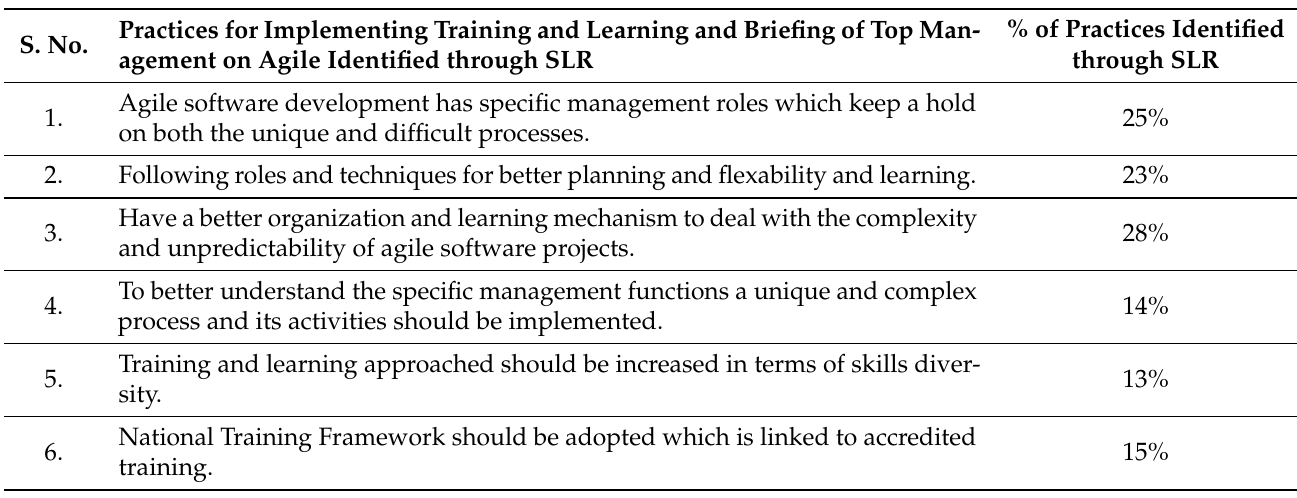
Table 22. Practices for implementing training and learning and briefing of top management on agile.